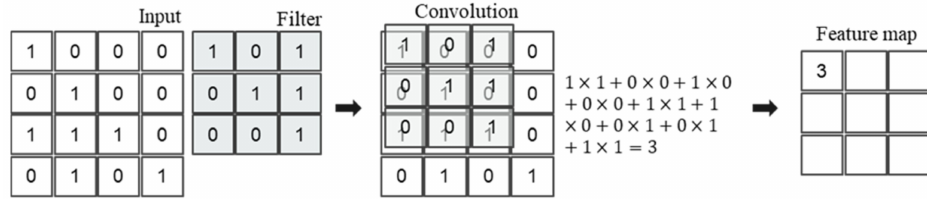
Figure 1. Convolution operation with 4 × 4 input data.